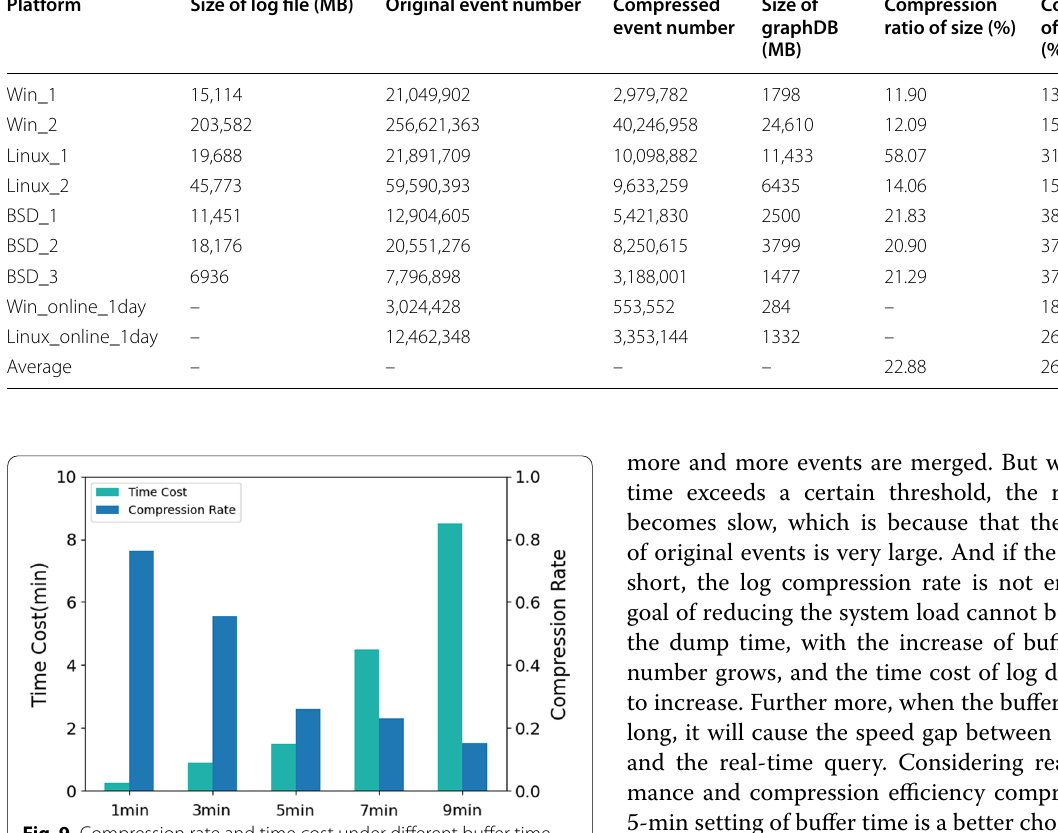
Table 8 Space occupation of different dataset Platform